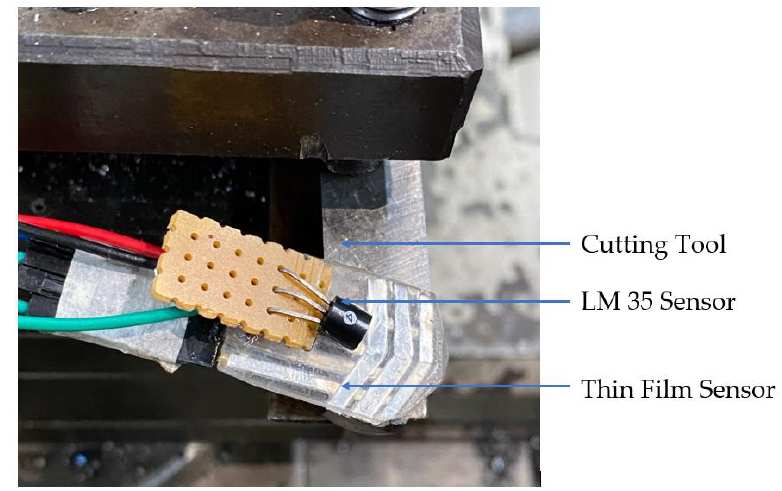
Figure 7. Thick film sensor and LM35 sensor at the tooltip.